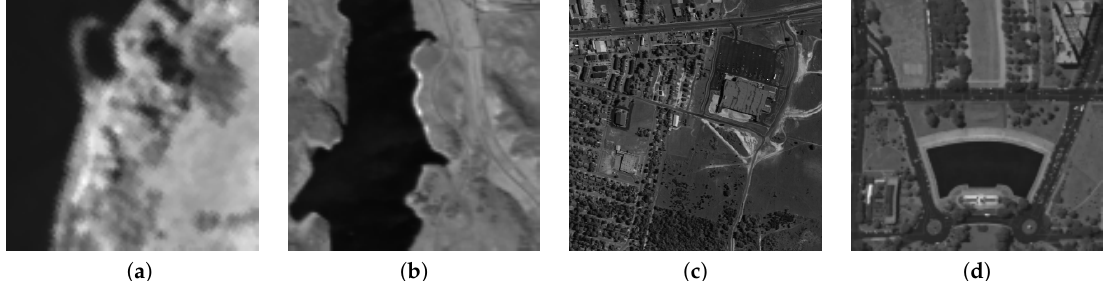
Figure 2. Hyperspectral test images (the result of averaging the band images is displayed as a grayscale image): ( a ) Samson, ( b ) Jasper Ridge, ( c ) Urban, and ( d ) Washington DC.